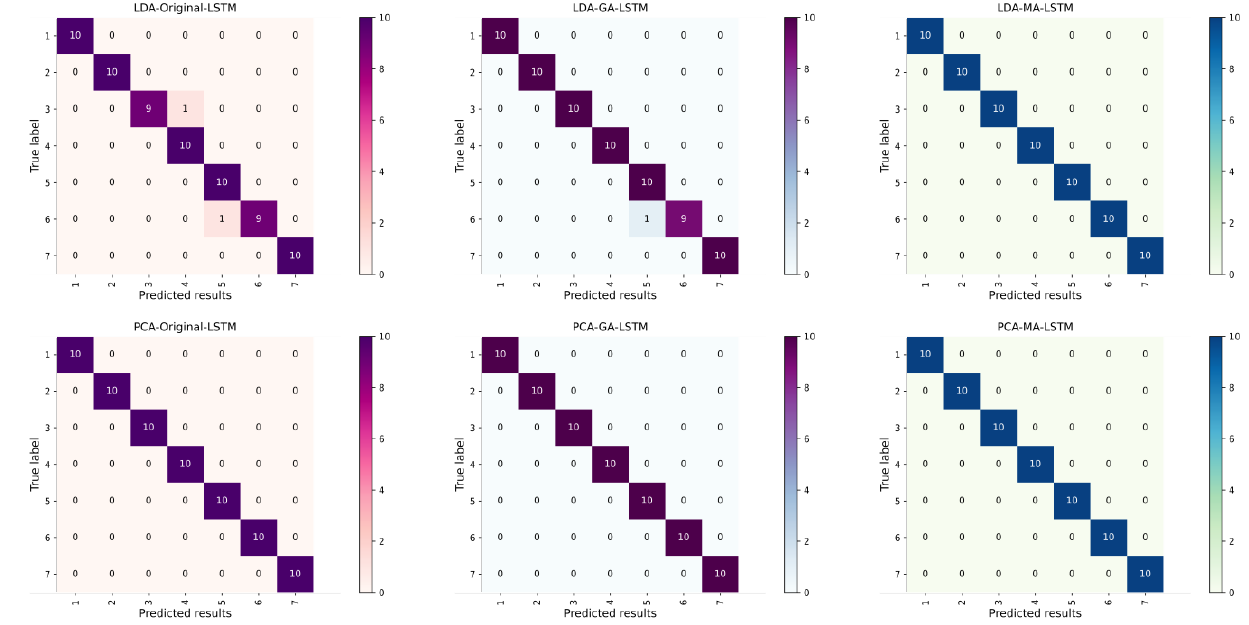
Figure 5. Multi-category confusion matrix.